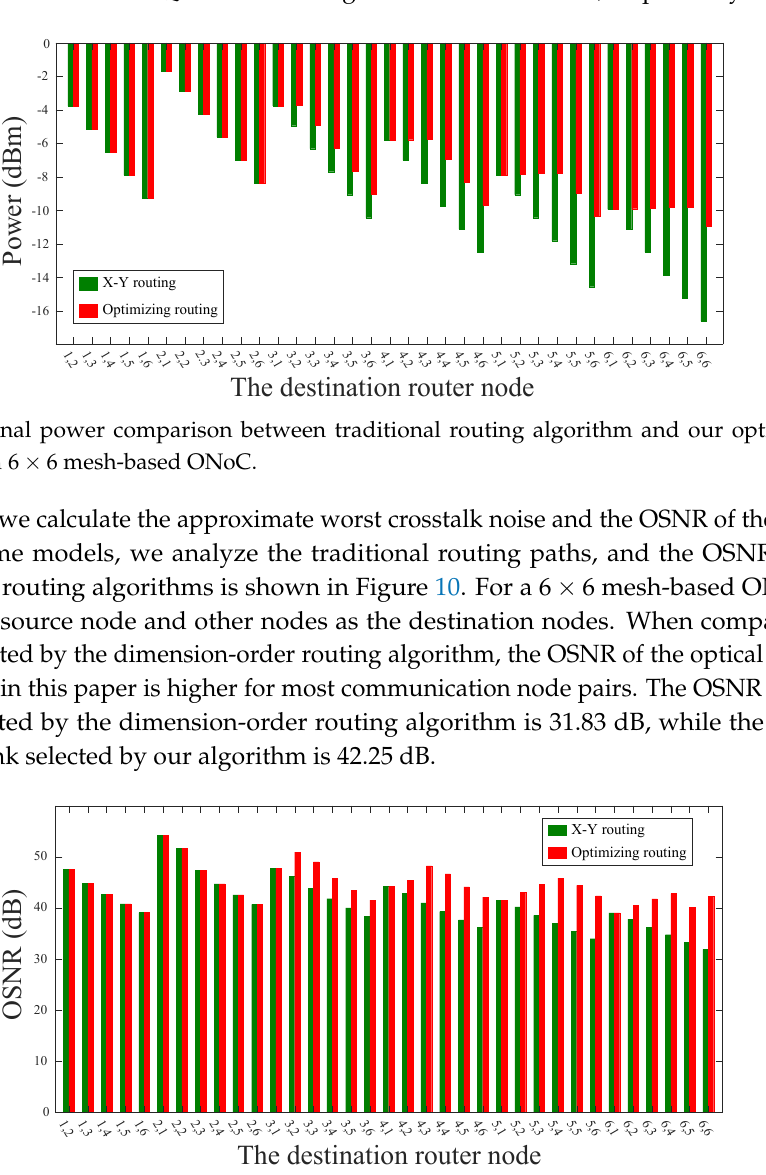
Figure 10. OSNR comparison between traditional routing algorithm and our optimization algorithm in a 6 × 6 mesh-based